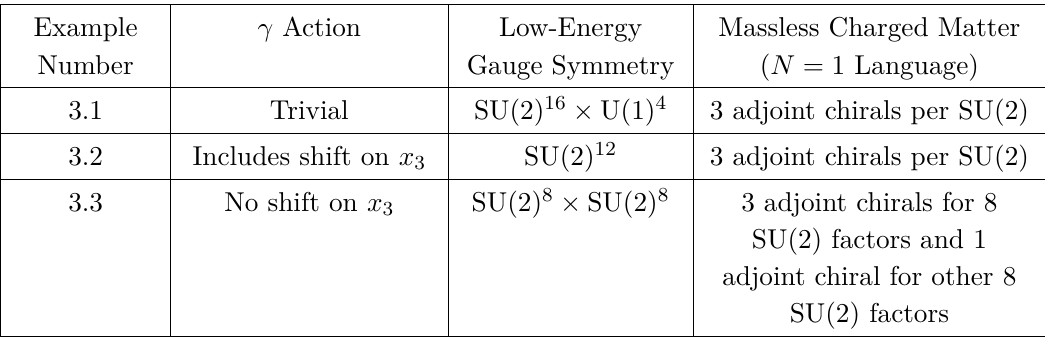
Table 1 . Summary of spectra of M-Theory